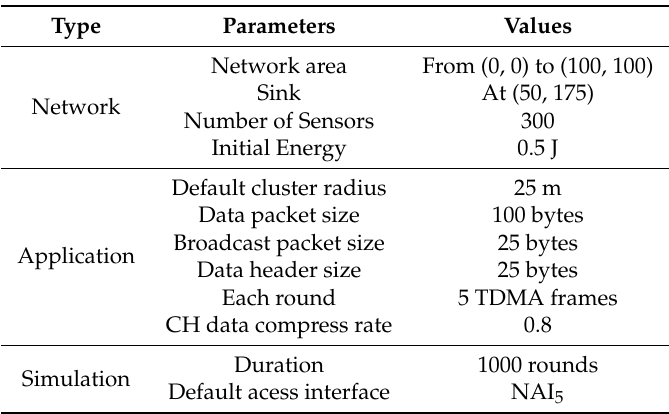
Table 9. Simulation